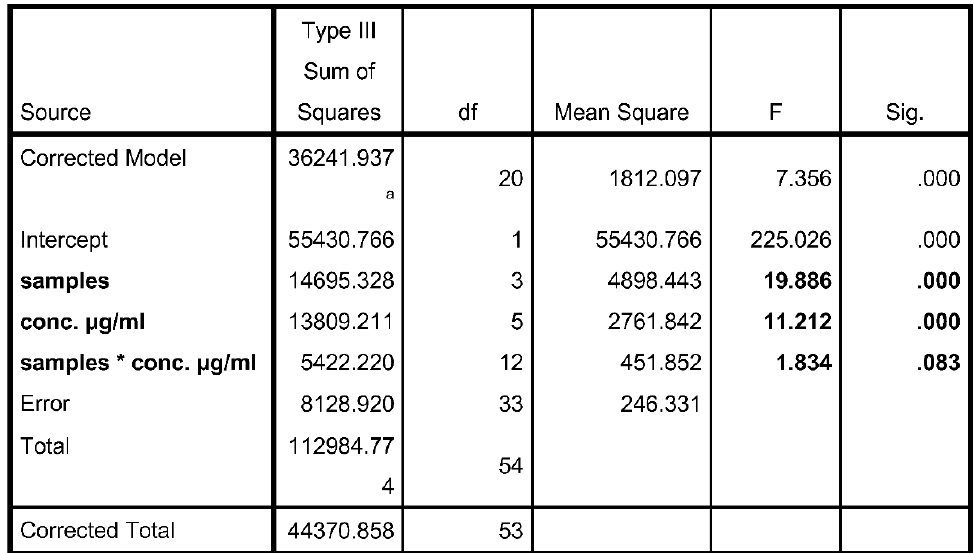
Molecules 2021 , 26 , x FOR PEER REVIEW Figure 2. a. R Squared = 0.817 (Adjusted R Squared = 0.706) . Figure 2. a. R Squared = 0.817 (Adjusted R Squared = 0.706).